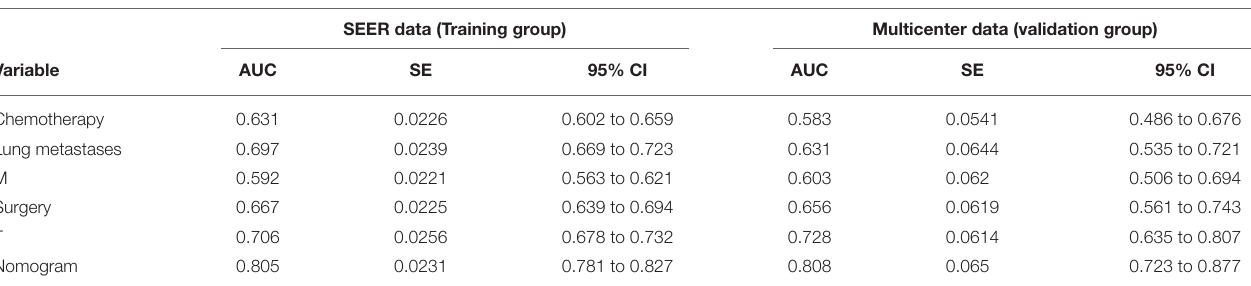
TABLE 4 | AUC of training group and validation